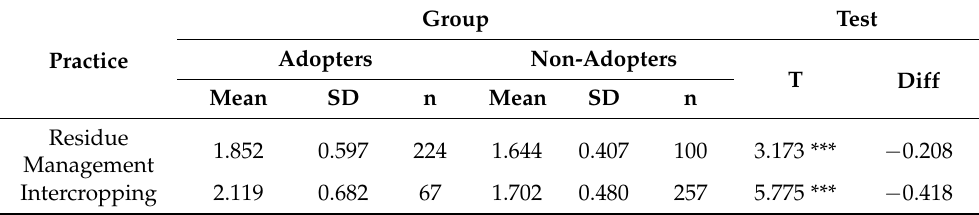
Table 6. Results of t -tests and descriptive statistics of soil carbon by soil conservation